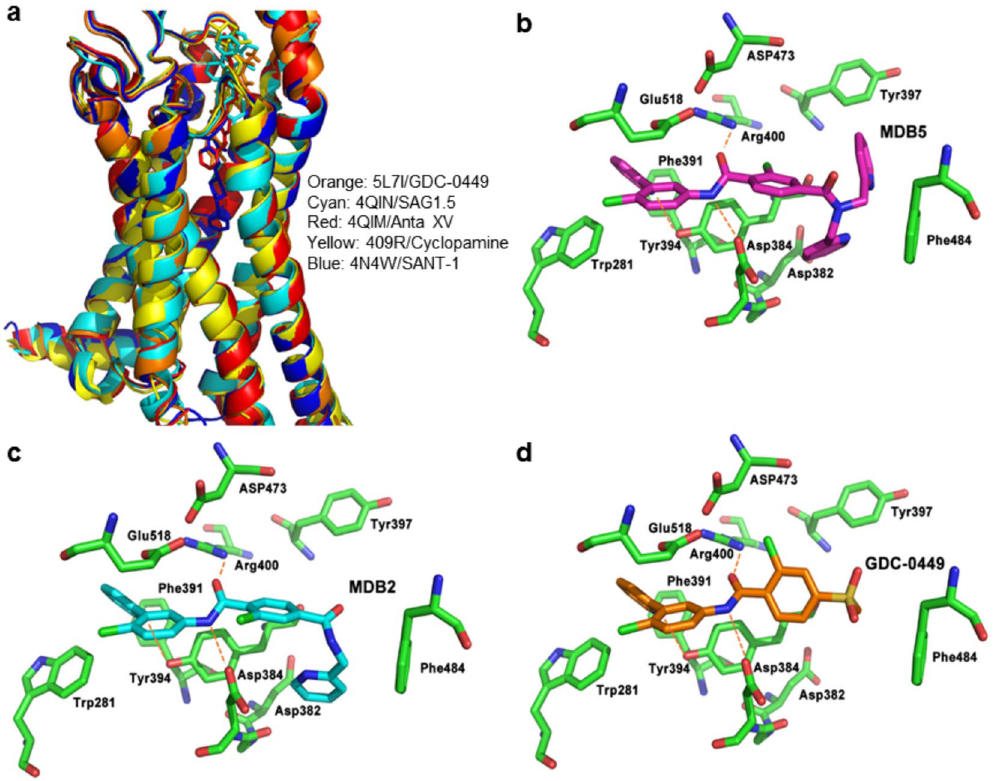
Figure 3. Molecular docking of GDC-0449 analogs in human Smo. ( a ) Binding pocket of Smo as defined by superposition of five crystal structures of human Smo (PDB ID: 5L7I, 4QIM, 4QIN, 4O9R and 4N4W). Structures and ligands were colored coded as noted. Smo/ligand interactions for MDB5 ( b ), MDB2 ( c ) and GDC-0449 ( d ). The hydrogen-bond interactions are depicted as orange dotted